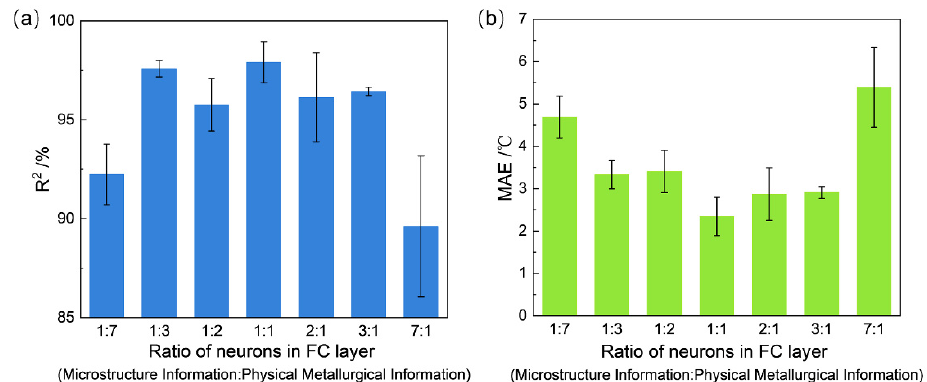
Figure 6. The results of the CNN models with different ratio of the neuron amount for image data and numerical data: ( a ) the results of R 2 ; ( b ) the results of MAE.